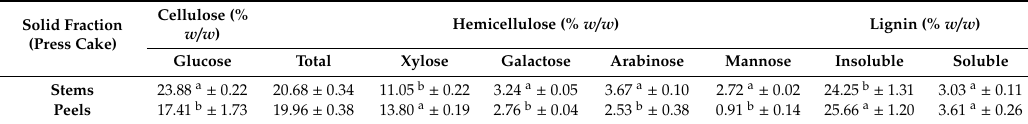
Table 3. Structural carbohydrates composition of pineapple by-products (peels and stems) of the solid fraction (press